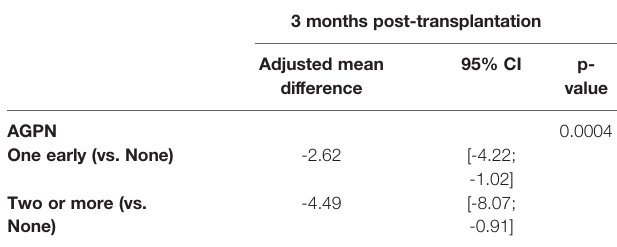
TABLE 6 | Results of the multivariable linear mixed model of eGFR (ml/min/ 1.73m 2 ) including random intercept and random slope when the baseline was set at 3 months